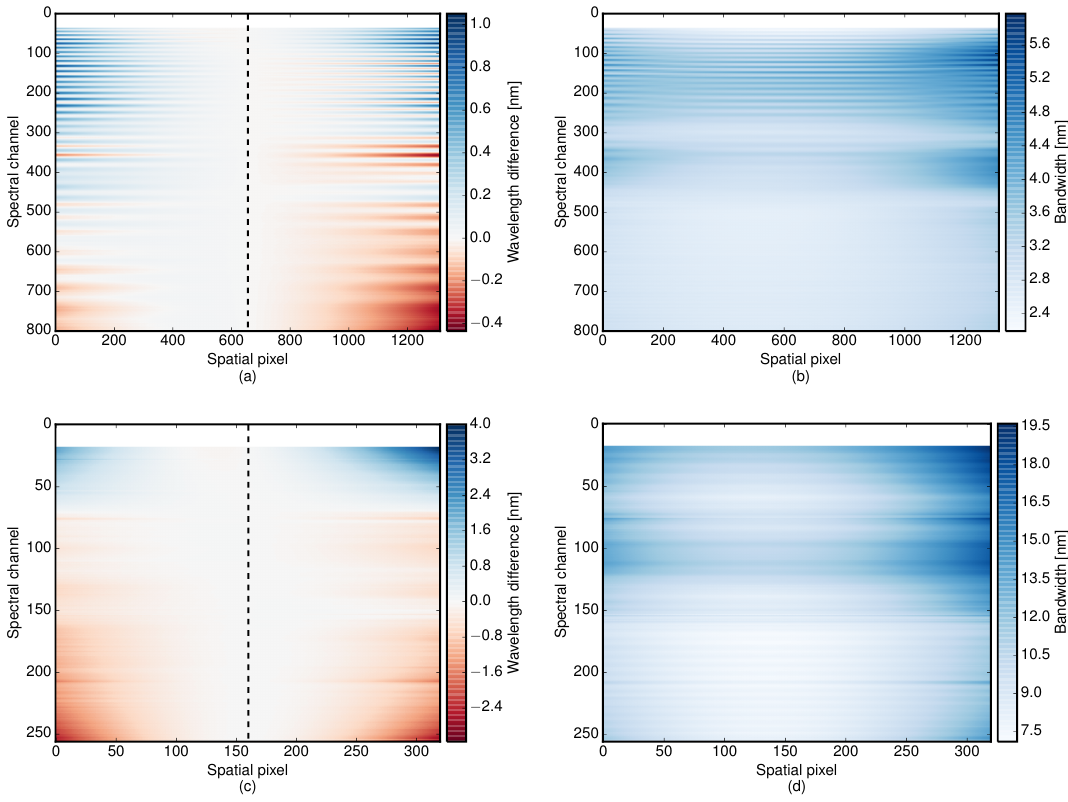
Figure 18. Spectral characterization results of the VNIR (top) and SWIR (bottom) sensor. Panels (a) and (c) show the difference of the wavelength of each channel to those of pixel 656 (VNIR) and pixel 160 (SWIR) respectively. Panels (b) and (d) show the bandwidth. White areas indicate channels which are excluded from evaluation due to their low sensitivity.